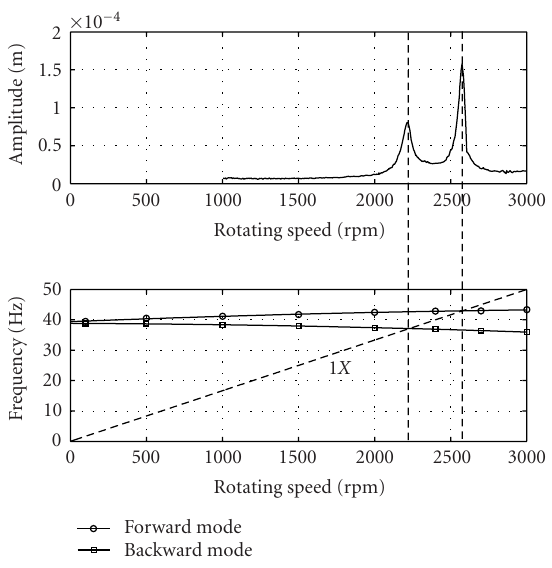
Figure 9: Measured unbalance responses in the horizontal direction at sensor location B 1. (a) The first response, at 2225 rpm, is the first backward critical speed. (b) The first response, at 2580, is the first forward critical